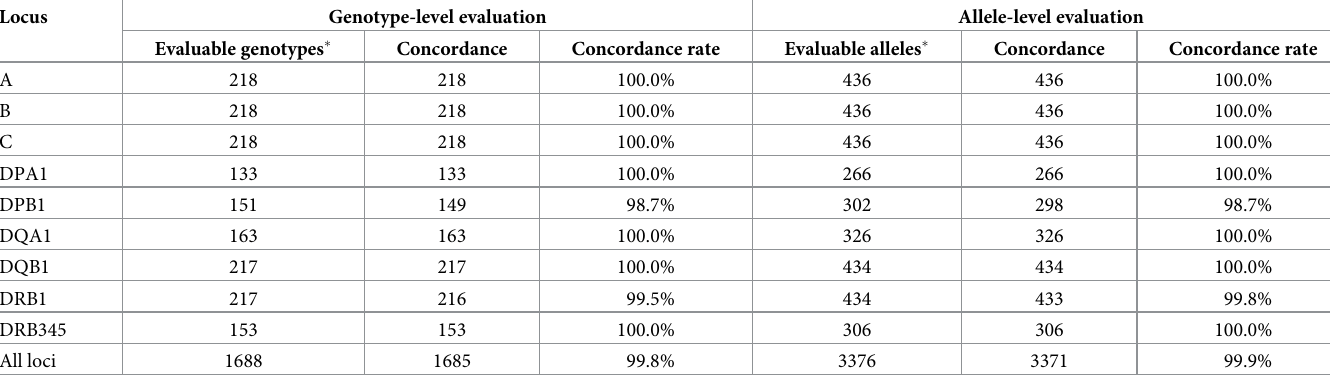
Table 2. Concordance at the genotype and allele levels. Locus Genotype-level evaluation Allele-level evaluation Evaluable genotypes